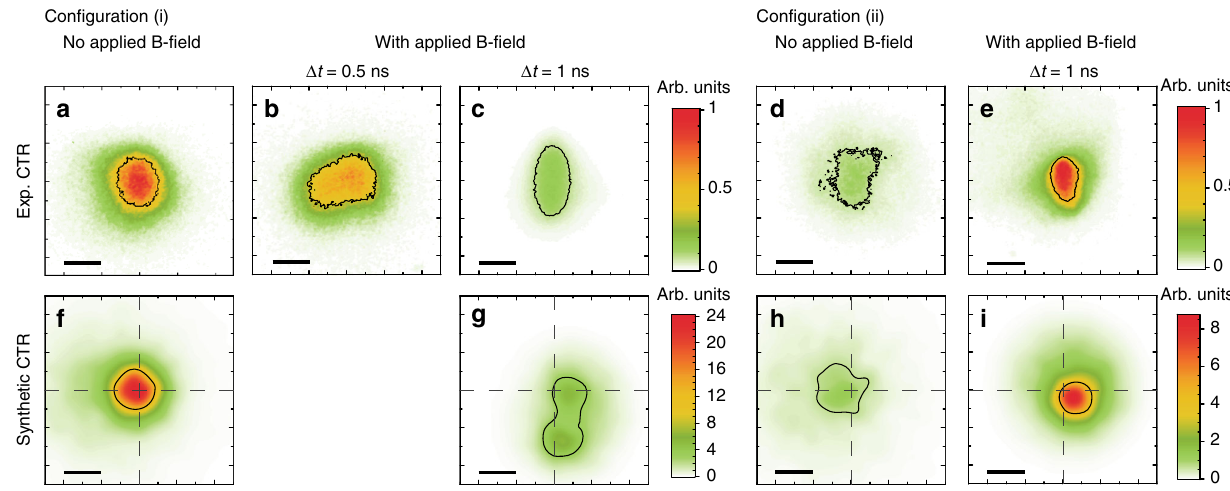
Fig. 2 Experimental and synthetic images of the coherent transition radiation. Coherent transition radiation (CTR) is produced at the transport targets ’ rear surface when relativistic electrons cross the boundary between the target and vacuum. a – e Experimental data and f – i synthetic CTR calculated from 3D PIC-hybrid simulations of fast electron transport, for the two con fi gurations (i) target out of the coil plane and (ii) target at the coil plane (Fig. 1), with and without imposed B- fi eld. The black horizontal bars, corresponding to 20 μ m, give the spatial scale at the emitting target surface. The contour lines correspond to the half-height of the signals. The crossed dashed lines indicate the position of REB injection at the targets ’ front laser-irradiated surface. The synthetic images are calculated at the end of the simulation runs and account for all particles having reached the targets ’ rear